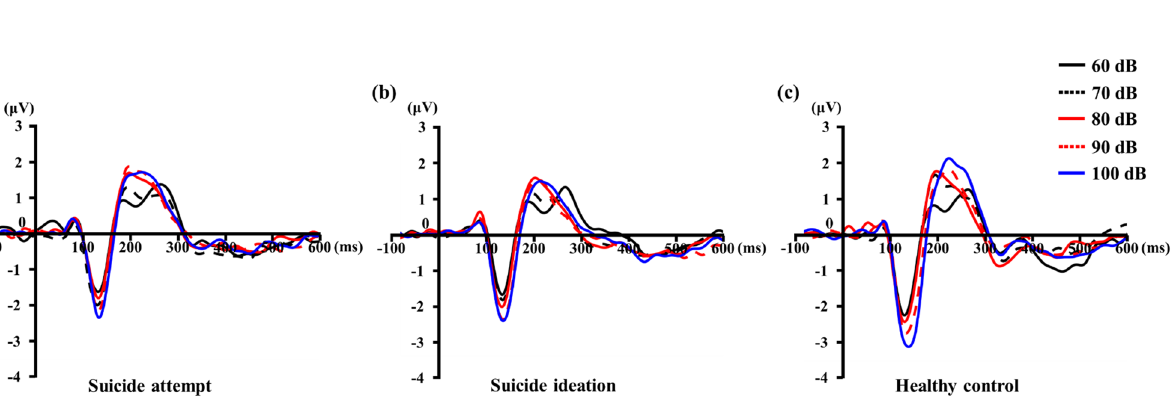
Figure 1. Grand average of loudness dependence of the auditory evoked potentials (LDAEP) event-related potentials (ERPs) at the Cz electrode for major depressive disorder (MDD) patients with: suicide attempts ( A ) and suicidal ideation ( B ), and healthy controls ( C ). The auditory stimuli were generated with E-Prime